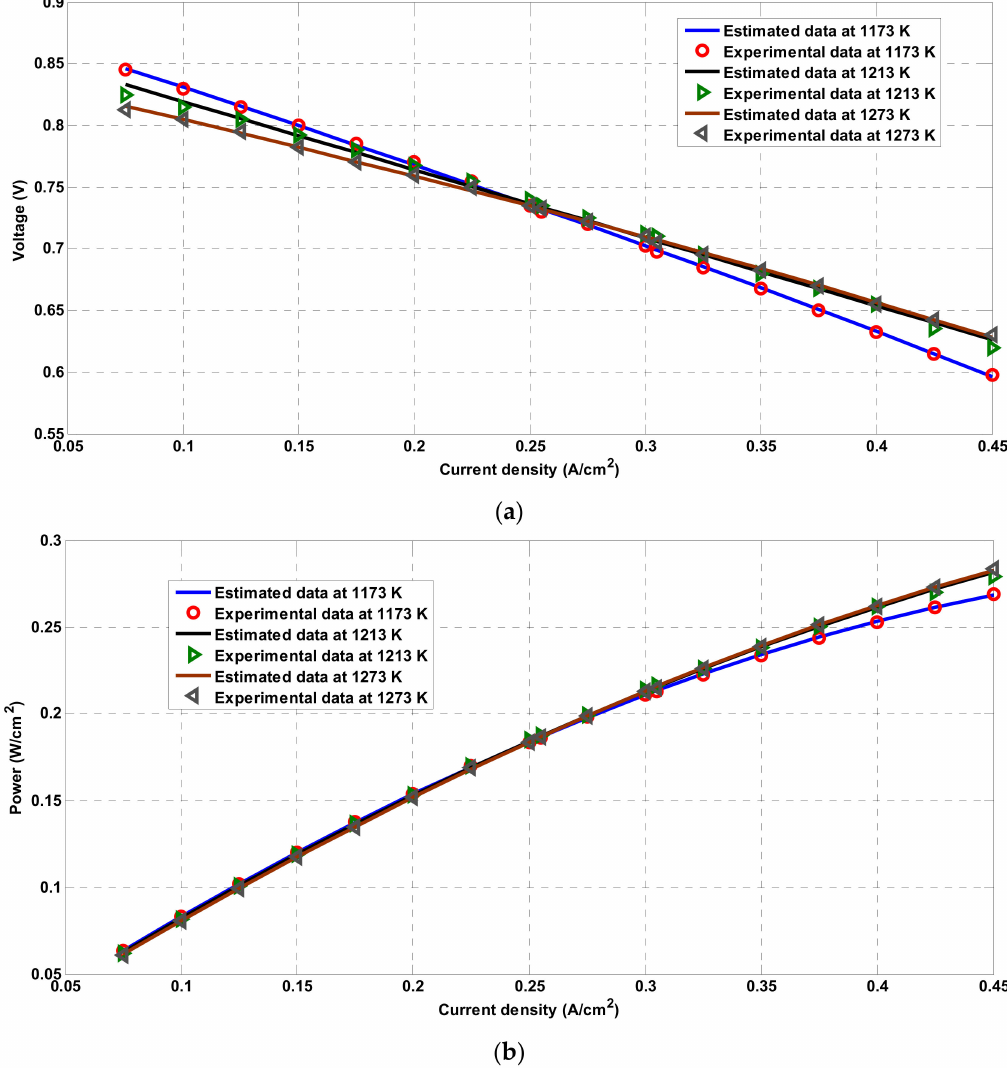
Figure 6. The measured and calculated ( a ) current density-voltage, ( b ) current density-power of SOFC operated at 1173 K, 1213 K, and 1273 K obtained via the proposed